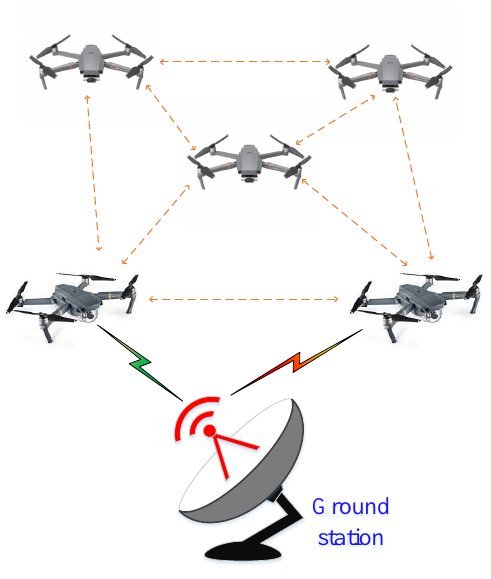
Figure 6. The distributed control scheme for multiple